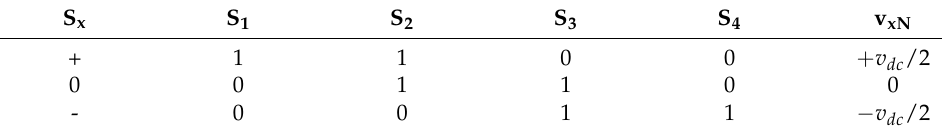
Figure 3. T-type fundamental cell. Table 1. Switching states of the T-type inverter fundamental